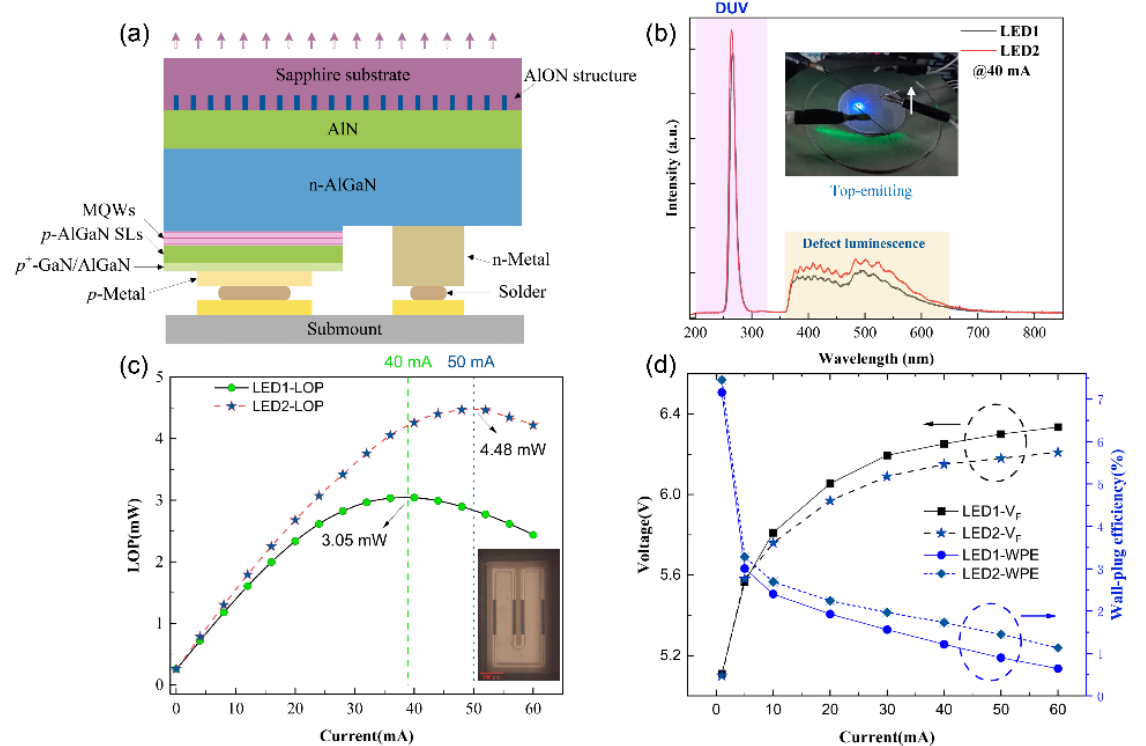
Figure 6. ( a ) Structure diagram of a 265 nm LED2 flip-chip structure; ( b ) EL spectrum of an epitaxial wafer at 40 mA; ( c ) light-emitting surface of a 265 nm LED chip; ( d ) electrical performance test results of LED1 and LED2.